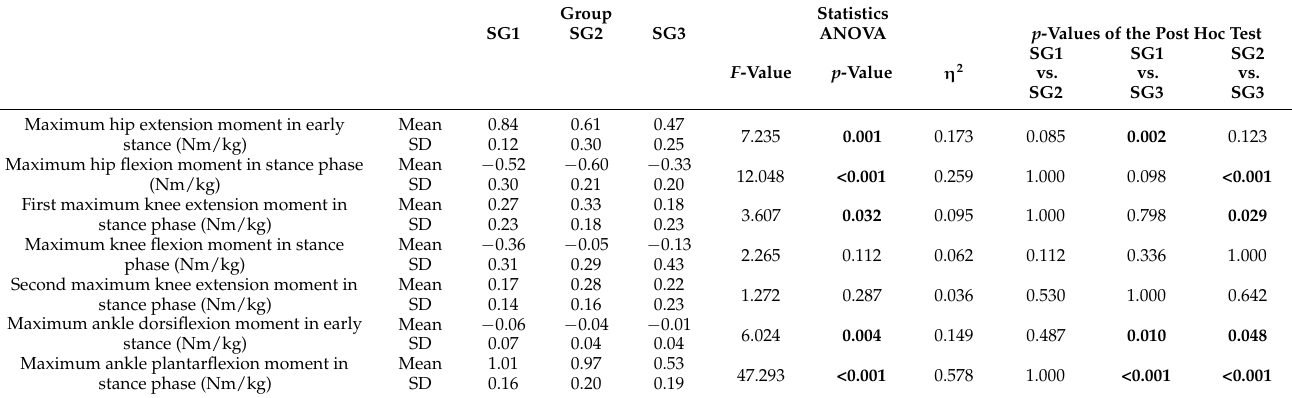
Table 4. Representative kinetic parameters in paretic lower limb during walk in the three subgroups. Group Statistics SG1 SG2 SG3